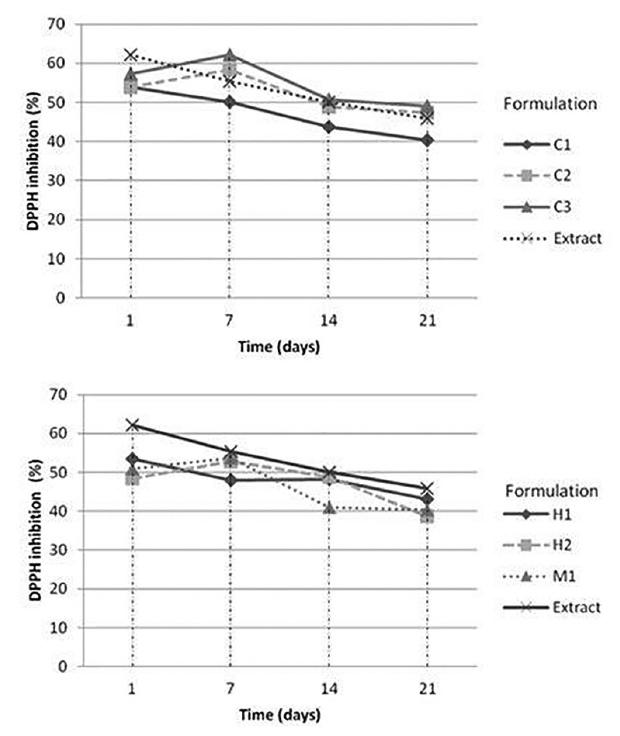
FIGURE 5 - Percentage inhibition of DPPH radical of formulations for a period of 21 days to the formulations.